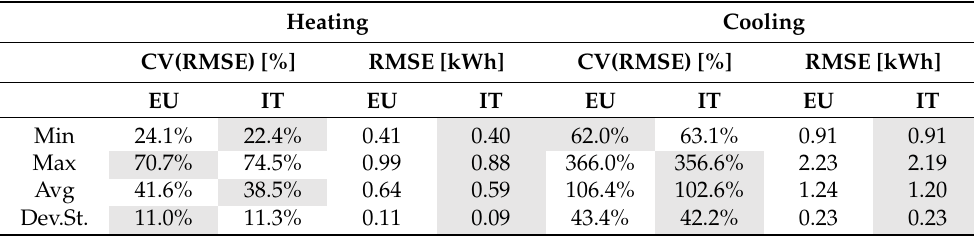
Table 10. Minimum, maximum, average and standard deviation value of CV(RMSE) and the RMSE of both methods of EN ISO 52016 (Annex A and Annex B). Case study with g gl,n = 0.34. The gray cells show the best